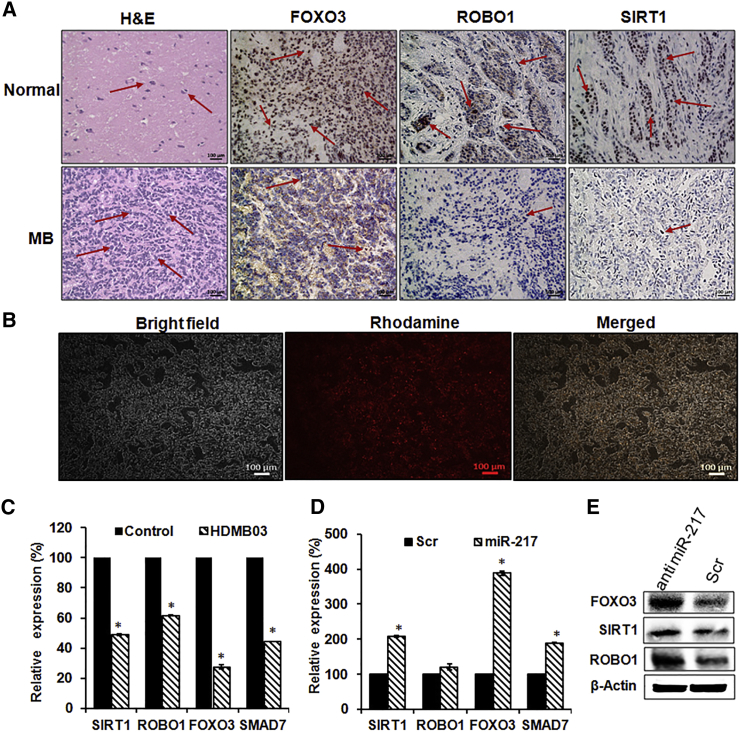
Expression and Validation of Various Targets of miR-217(A) H&E and immunohistochemical staining for FOXO3, ROBO1, and SIRT1 protein in normal and MB patient tissues. Scale bars, 100 μm. Arrows indicate the stained cells. (B) Transfection of a labeled oligonucleotide using Lipofectamine RNAiMAX in HDMB03 cells. (C) The expression levels of FOXO3, ROBO1, SIRT1, and SMAD7 gene were measured and compared with that of the control cell line (SVG p12). Validation of regulation of miR-217 targets by (D) real-time PCR and (E) western blot in the HDMB03 cell line. The expression level of each gene and protein was measure and compared with scrambled (Scr) miR-217- and antimiR-217-transfected cells. The RT-PCR was performed with gene-specific primers. The expression of each gene was normalized with the average expression of the endogenous reference gene GAPDH. In western blot analysis, β-actin was used as a loading control. Data are shown as the mean ± SD of three separate experiments (Student’s t test; *p < 0.05; n = 3).